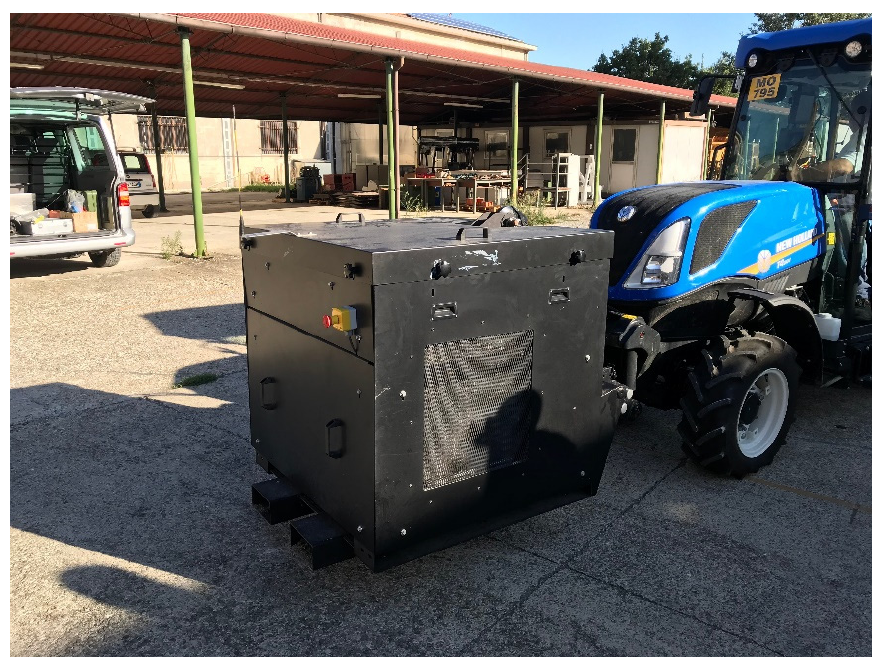
Figure 1. e-Source mounted on the New Holland T4.110V front linkage. The e-Source was run by the front PTO of the tractor, then the developed electric energy was modulated by a high voltage inverter controlled by the generator electronic control unit (GECU). The connection to the implements was granted by a standard AEF high-voltage power interface (AEF HVPI in the following) [15]. The operator could monitor and control the operation of the device through the virtual terminal of the tractor. The voltage output ( V eS ) was monitored by an embedded sensor, the output signal was acquired by a CAN-Bus datalogger described in the following. Further e-Source specifications are reported in Table